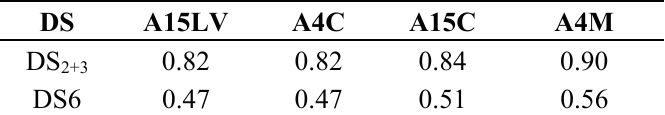
Table 1. Degrees of substitution in C-2 + C-3 (DS 2+3 ) and in C-6 (DS 6 ) of commercial methycellulose (MC) dissolved in DMSO-d 6 at 80 °C.